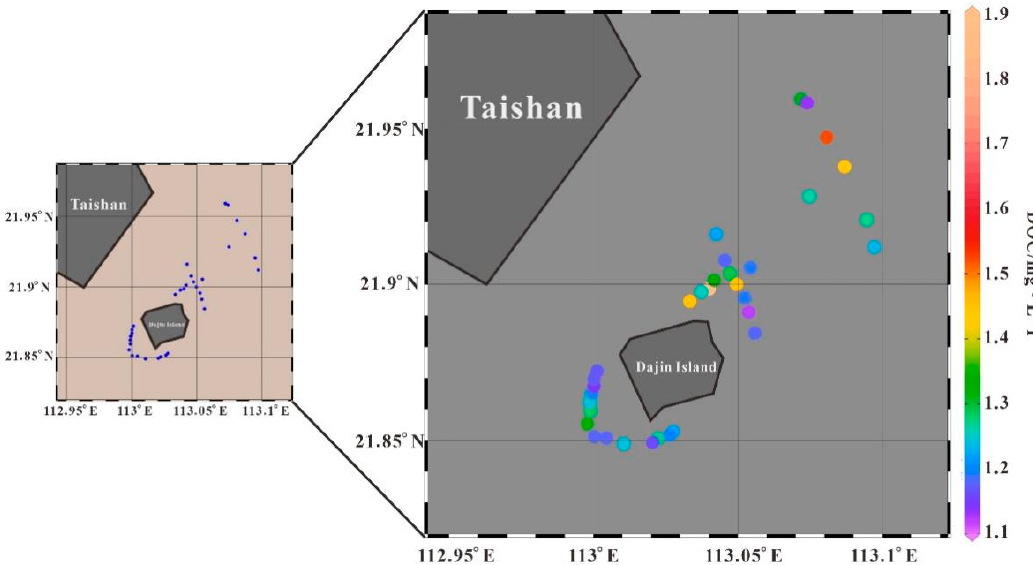
Figure 8. Distribution of measured DOC concentrations.